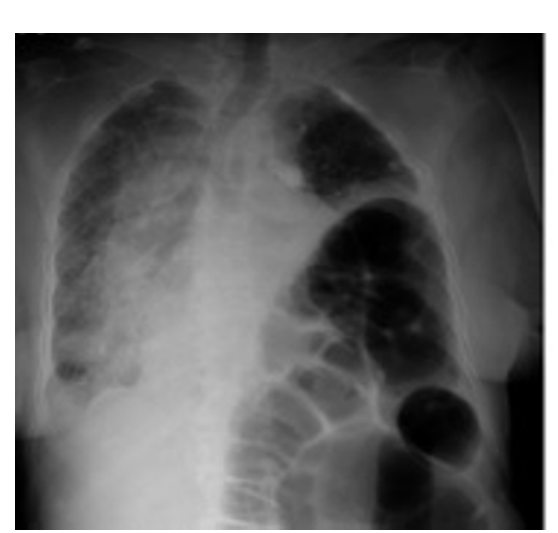
Figure 1. Chest X-ray at admission revealing severe diaphragm paralysis